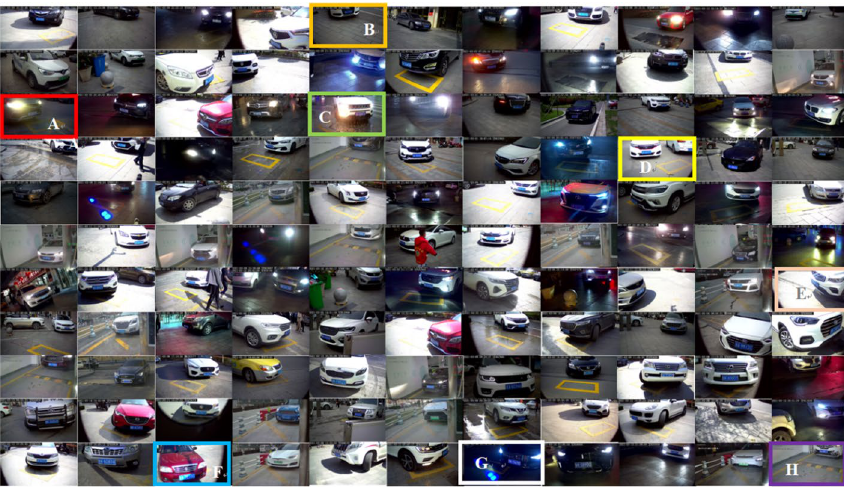
Fig. 4 The examples for the dataset of VLD100K-61. A High beam environment, B half-obscured, C rainy day, D multi-objects, E strong sunlight, F clear logo, G low illumination condition, H indoor parking